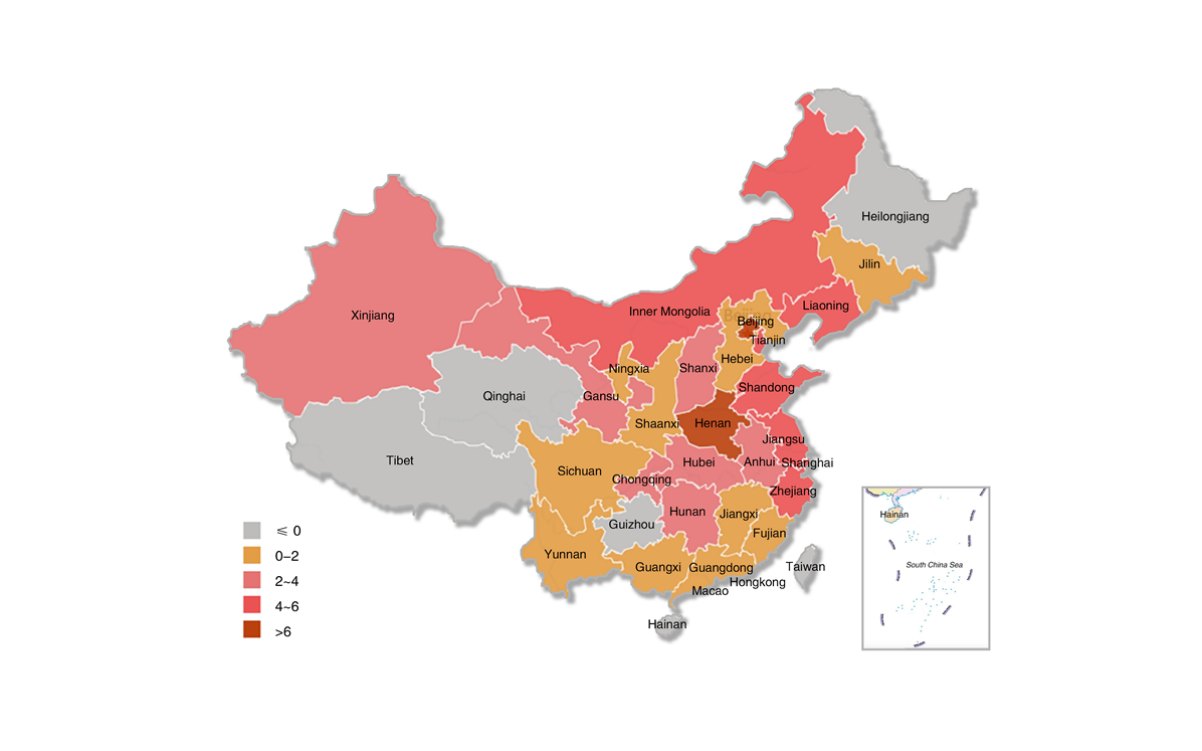
Figure 4. Diffusion of government Weibo accounts